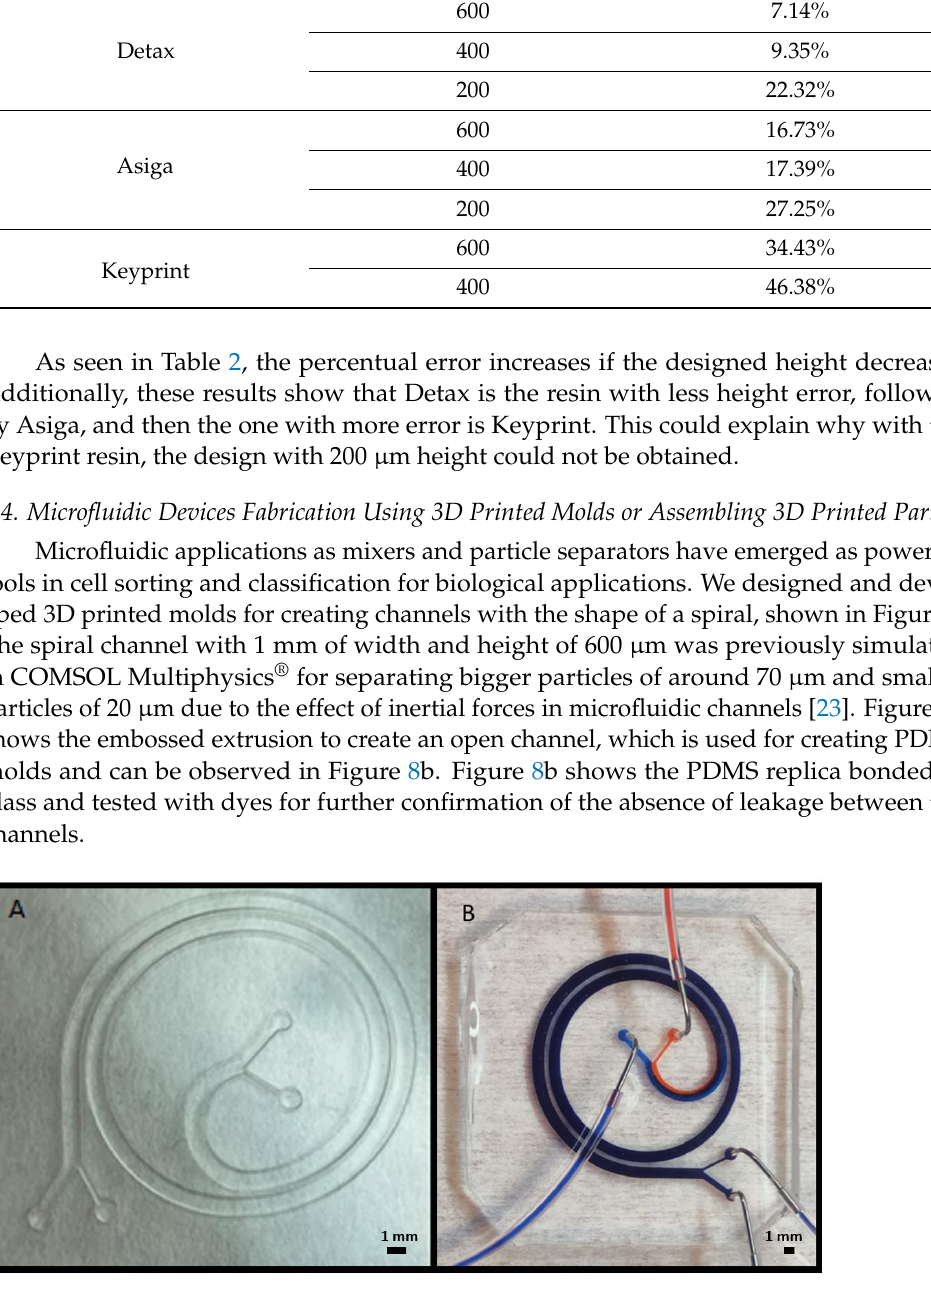
Figure 8. ( A ) 3D printed result with Detax resin of the extruded spiral, with a designed channel width of 1 mm and height of 600 µm. ( B ) Picture of the microfluidic system created with the PDMS replica based on the 3D printed part of ( A ).